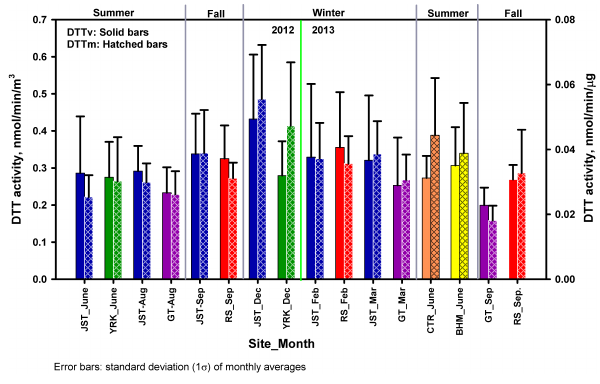
Figure 4. Monthly averages of volume- (DTTv) and mass- normalized (DTTm) DTT activity at the sampling